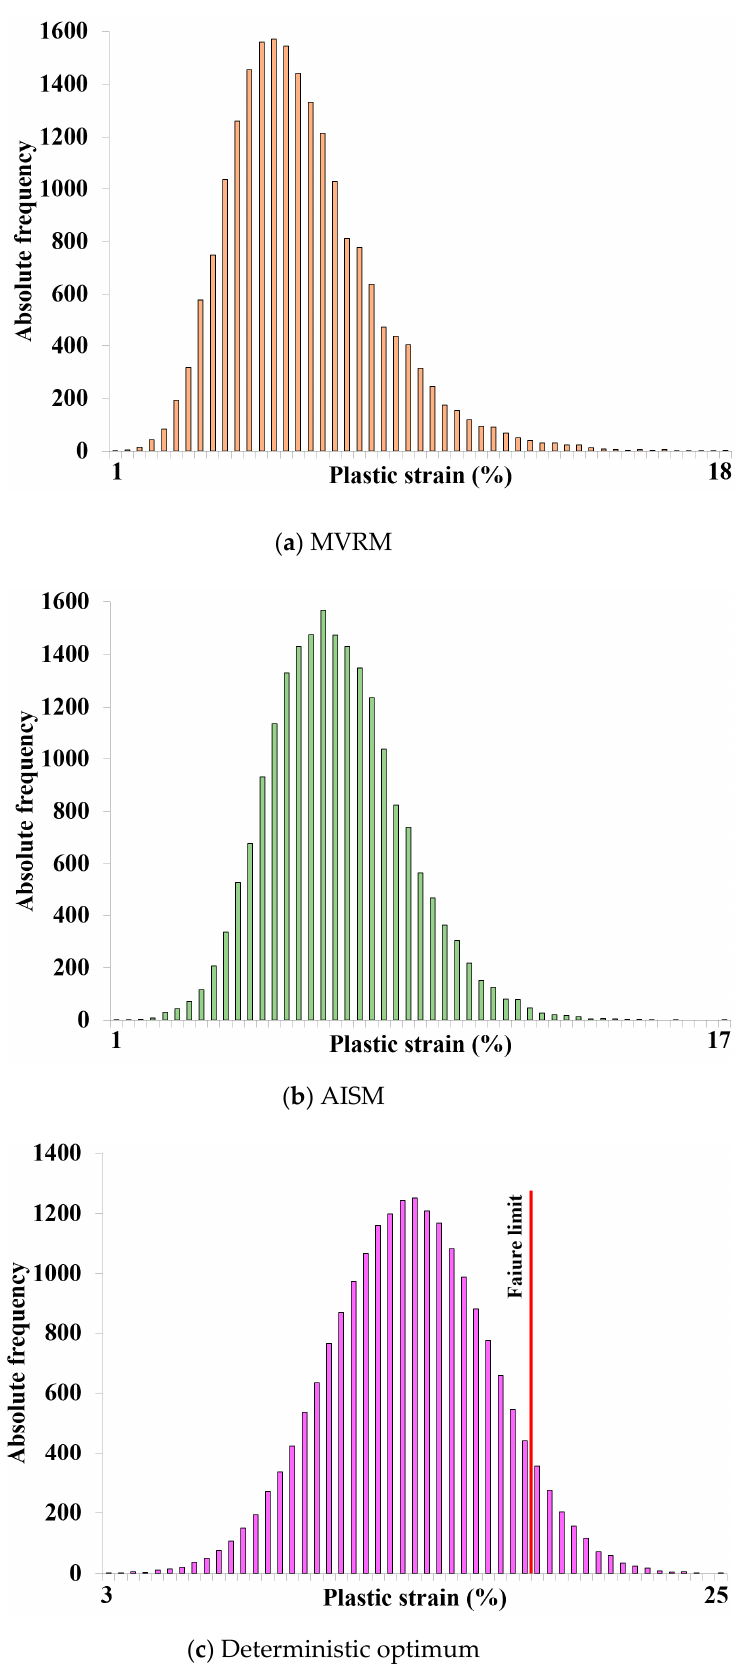
Figure 11. Comparison of PDF results for constraint function—plastic strain .